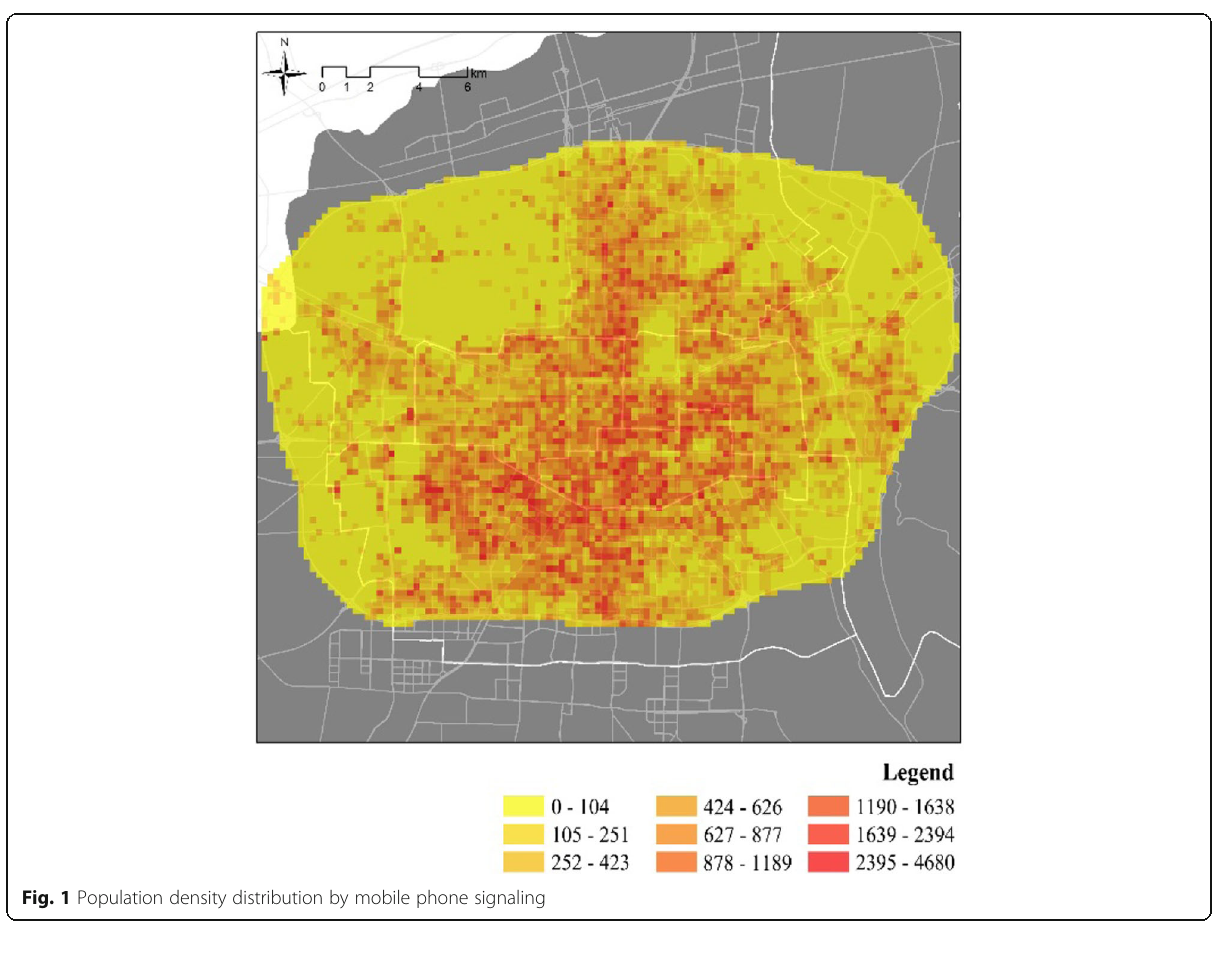
Fig. 1 Population density distribution by mobile phone